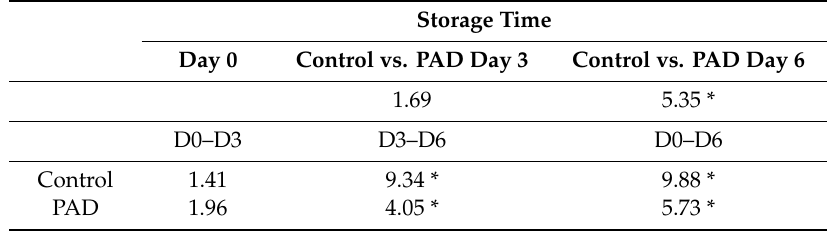
Table 2. Color di ff erences ( ∆ E) between groups and between storage